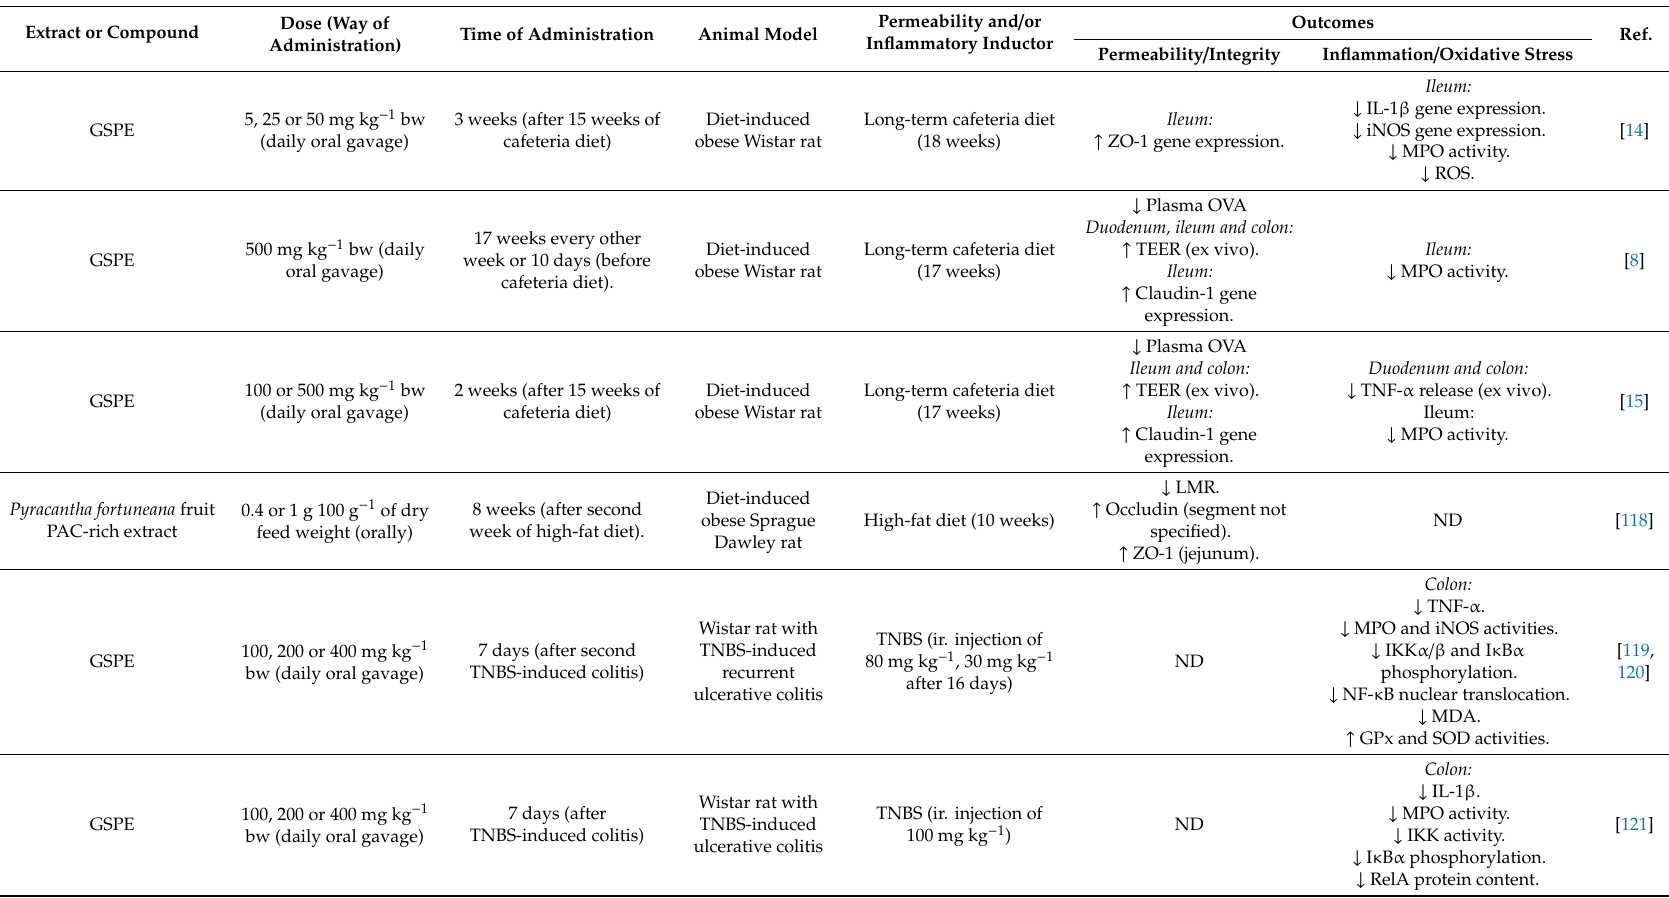
Table 2. Interaction of PACs with permeability and inflammatory markers in animal models of intestinal